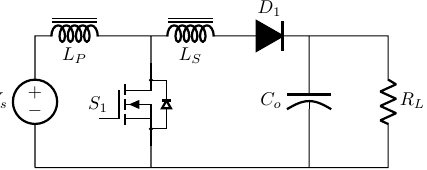
Figure 17. General Setup of the Coupled Inductor Circuit.